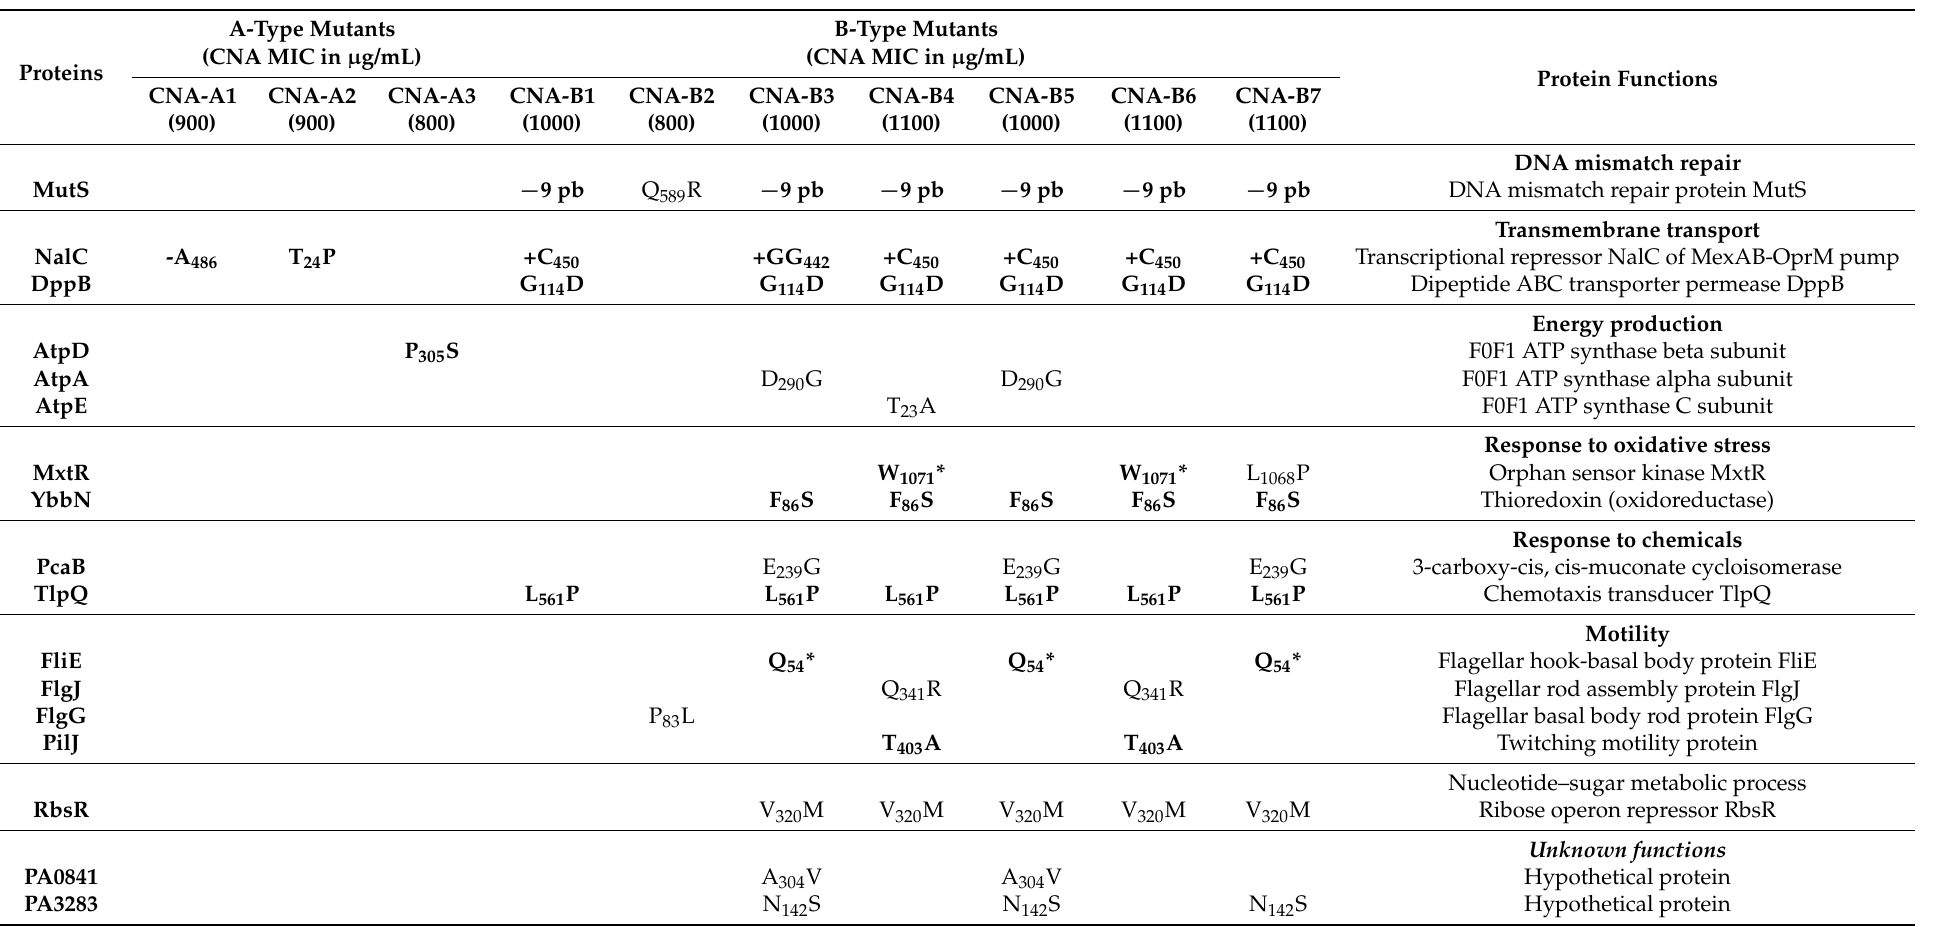
Table 2. Main genetic alterations of the CNA resistant